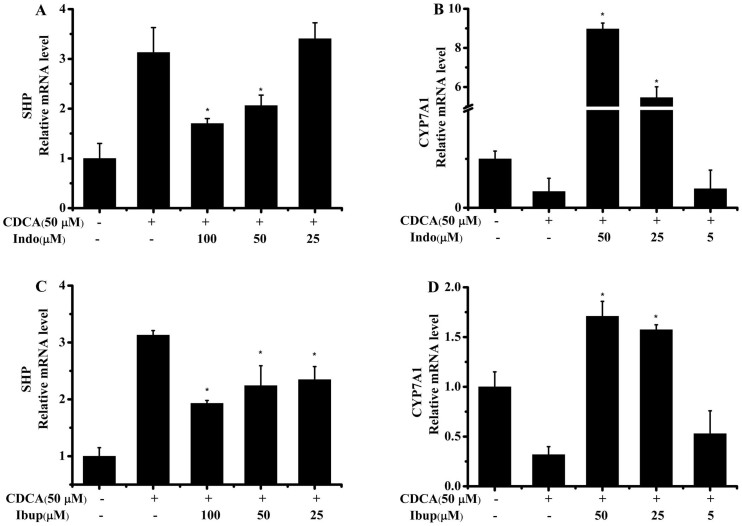
Indomethacin and ibuprofen regulate FXR downstream target gene mRNA expression in HepG2 cells.HepG2 cells were incubated with 50 μM CDCA alone or in combination with different concentrations indomethacin (A,B) or ibuprofen (C,D) for 24 h and cDNA synthesized from isolated mRNA served as template in qPCR experiments. The data were carried out in at least three independent experiments. Significance was determined by t test (*P < 0.05 versus cells treated with CDCA).